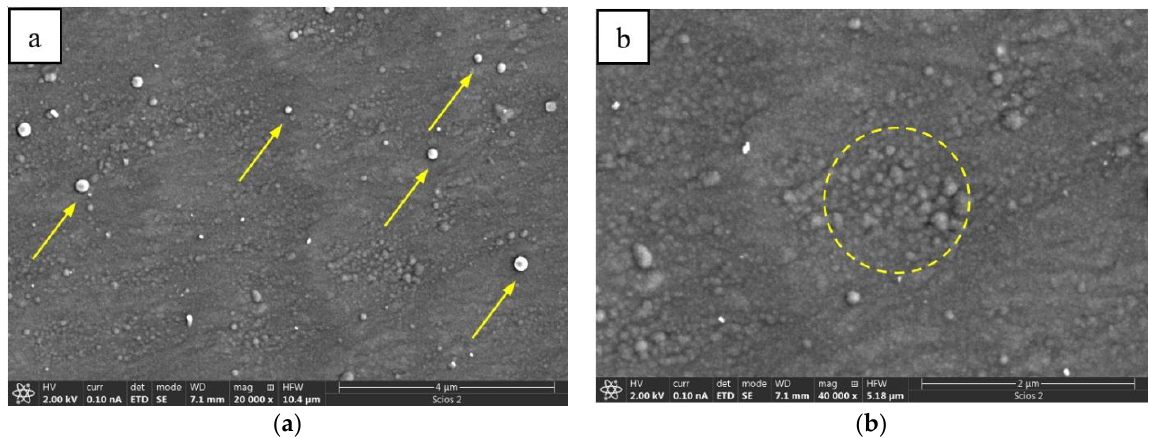
Figure 1. SEM/SE images of PN and carbon coated Ti-6Al-7Nb surface presenting: ( a ) pin-like defects (pointed with arrows) and ( b ) colonies of nodular objects (encircled with dashed line).